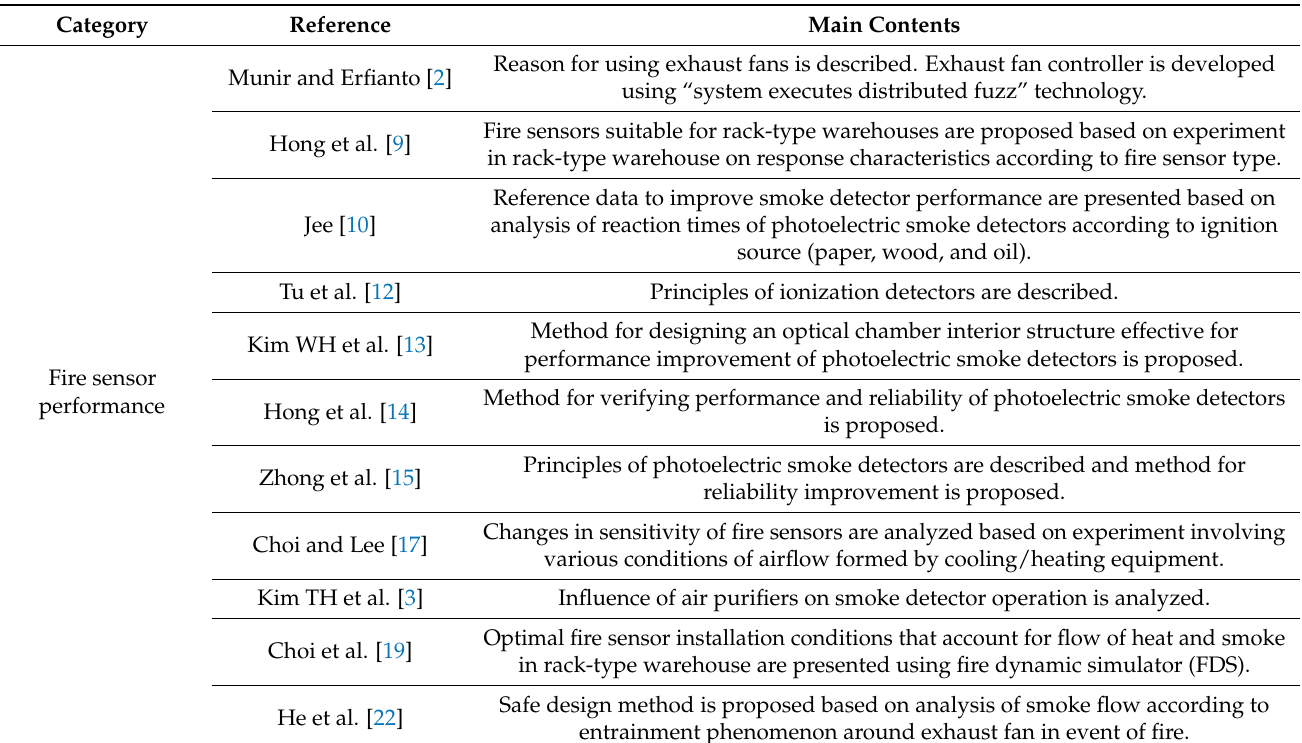
Table 1. Preliminary study